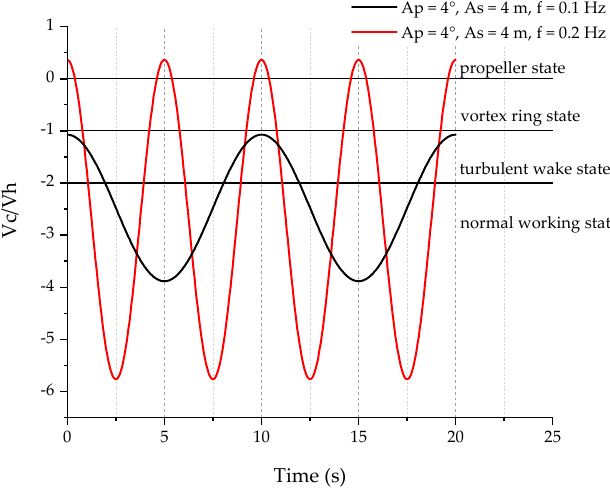
Figure 15. VRS identification scheme under same-phase combined motion.